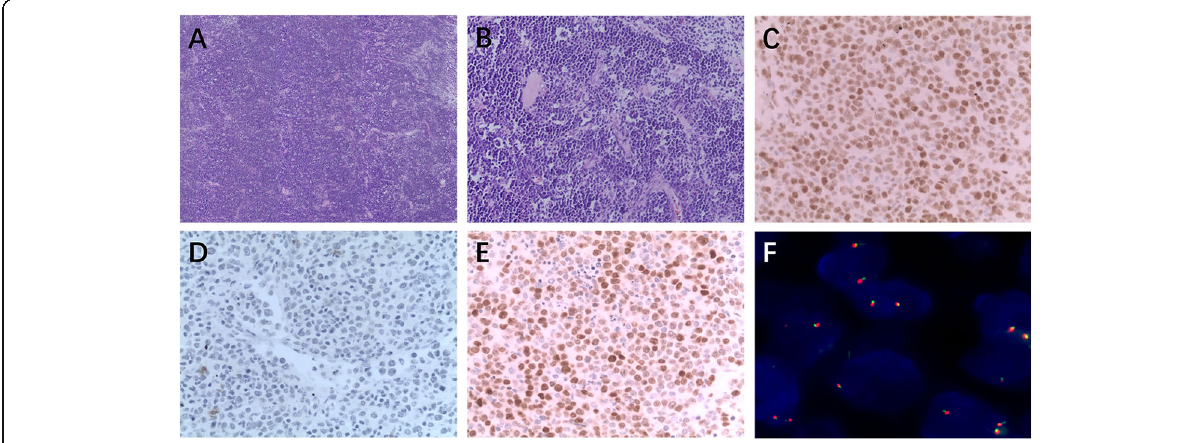
Fig. 2 High-grade B-cell lymphoma, not otherwise specified (HGBL, NOS) showing low- and high-magnification ( a , b ) LMO2 expression( c ) but not CD38 expression( d ) and c-Myc expression( e ); HGBL, NOSwith MYC nonrearranged( f